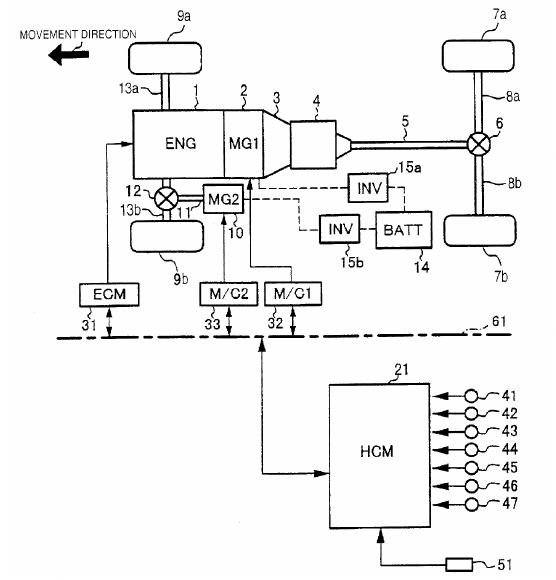
Figure 14. Schematic view of a drive transmission system of a vehicle equipped with a hybrid vehicle control apparatus according to